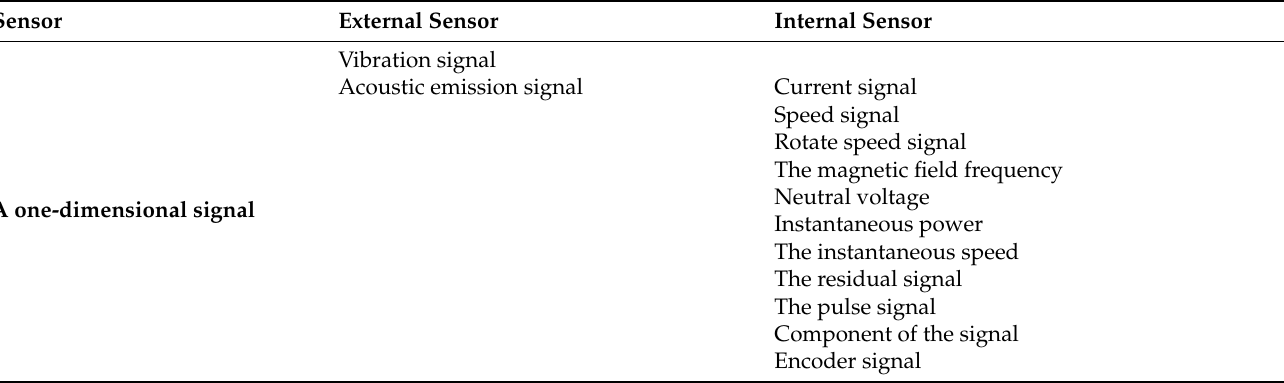
Table 1. A list of internal and external sensors with one-dimensional and two-dimensional